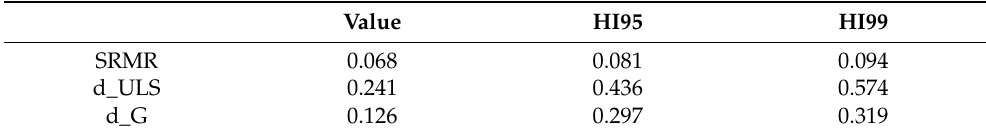
Table 2. Overall model